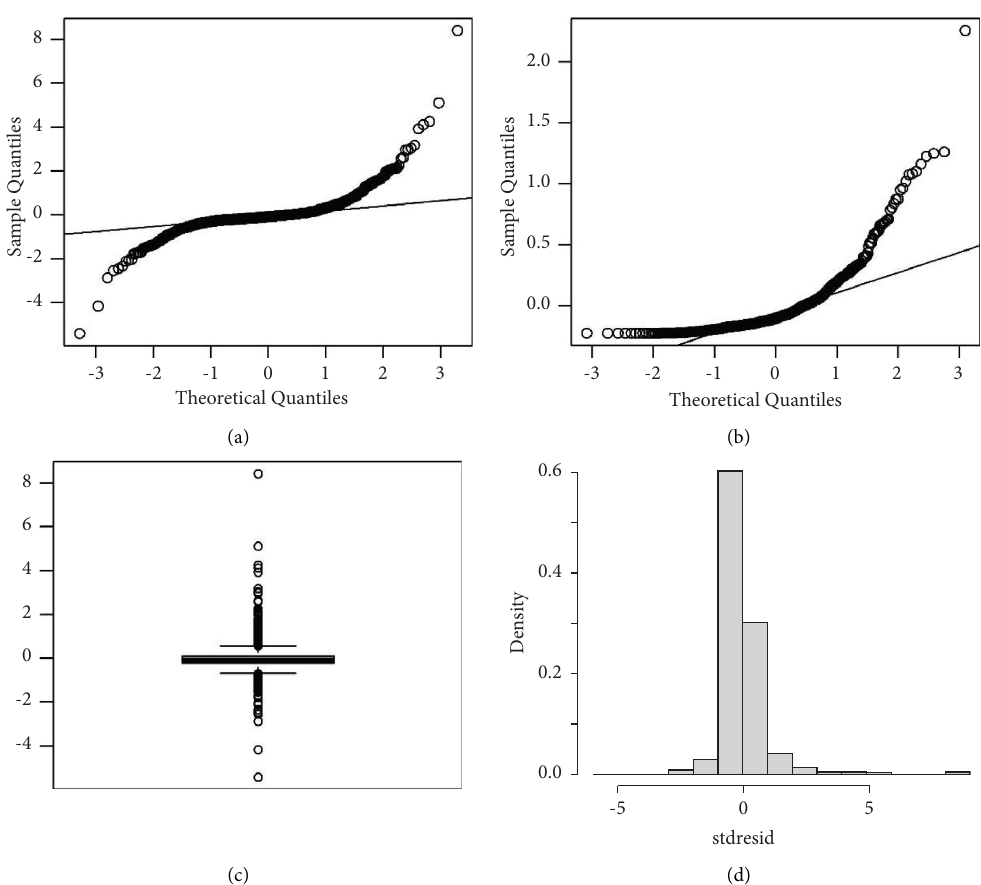
Figure 4: (a) Normal Q-Q plot of standardized residuals, (b) normal Q-Q plot of random efects, and (c, d) plots for box plot and histogram of standardized residuals.